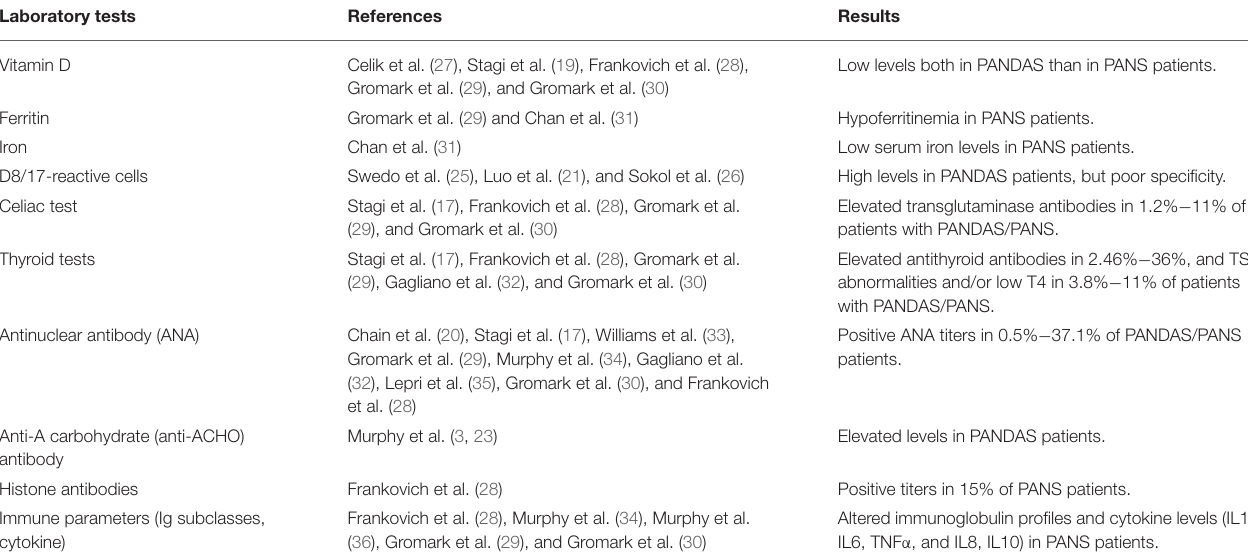
TABLE 3 | Studies about various laboratory tests in patients with PANDAS or